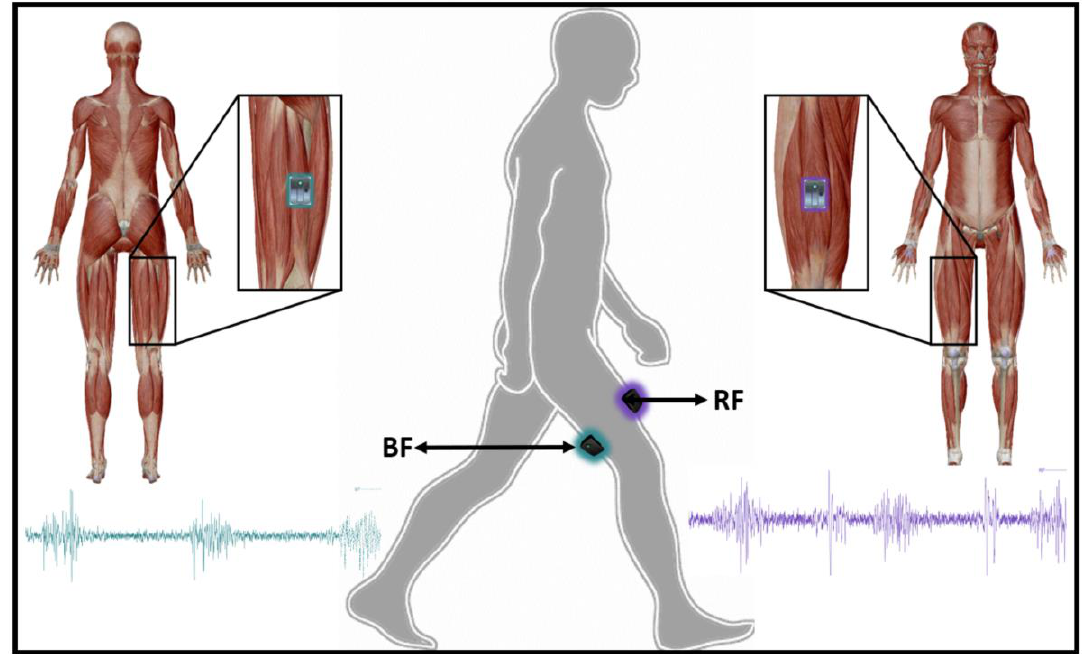
Figure 3. EMG sensors placement on selected muscles.